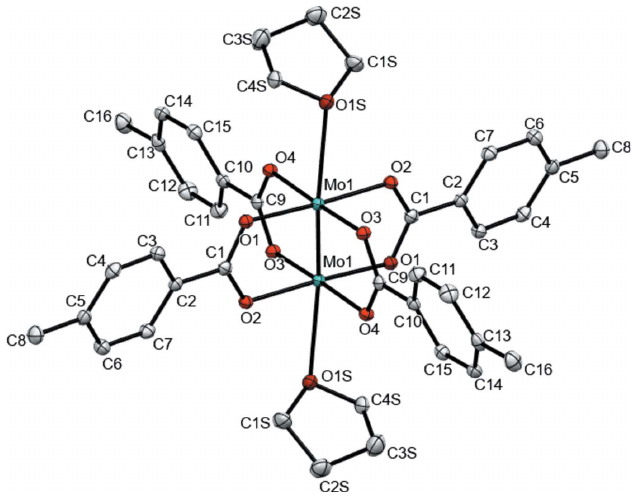
Figure 1 Ellipsoid plot of the title compound, with the atom-numbering scheme. Displacement ellipsoids are drawn at the 50% probability level. Hydrogen atoms and unbound THF solvent molecules are omitted for clarity. Color scheme: C (gray), O (red), Mo (teal). The Mo1 atom connects to its symmetry-generated atom with an Mo1—Mo1 i bond length of 2.1012 (4) A˚ [symmetry code: (i) (cid:5) x + 1, (cid:5) y , (cid:5) z + 1; Table